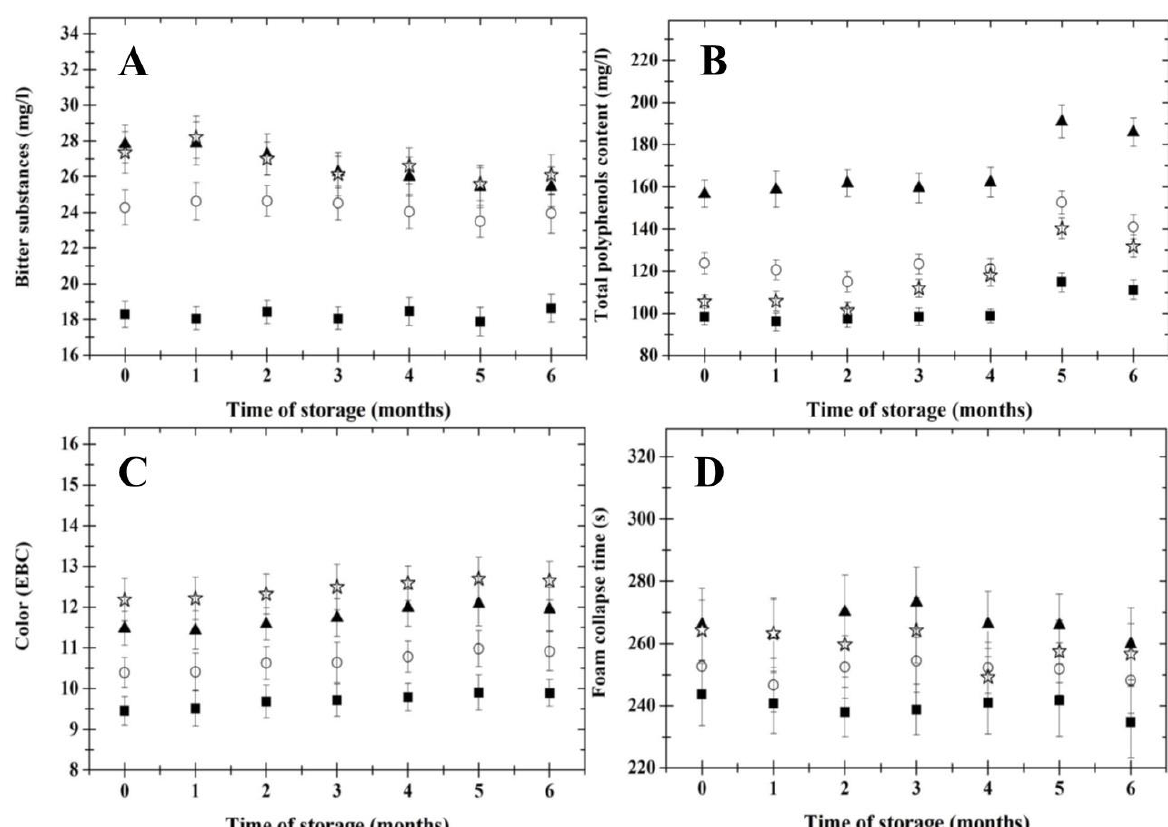
Figure 2. Development of bitter substances (mg/L; part A ), total polyphenol content (mg/L; part B ), color (EBC; part C ) and foam collapse time (s; part D ) of the Czech lager beer samples during a 6 months cold storage period at 4 ± 2 °C. The examined beer samples presented different original wort extract values ( ■ — 10.0% w / w ; ○ — 11.0 % w / w ; ▲ — 11.5% w / w ; ☆ — 12.0% w / w ). The results are ex- pressed as means; the error bars represent standard deviation ( n = 6).